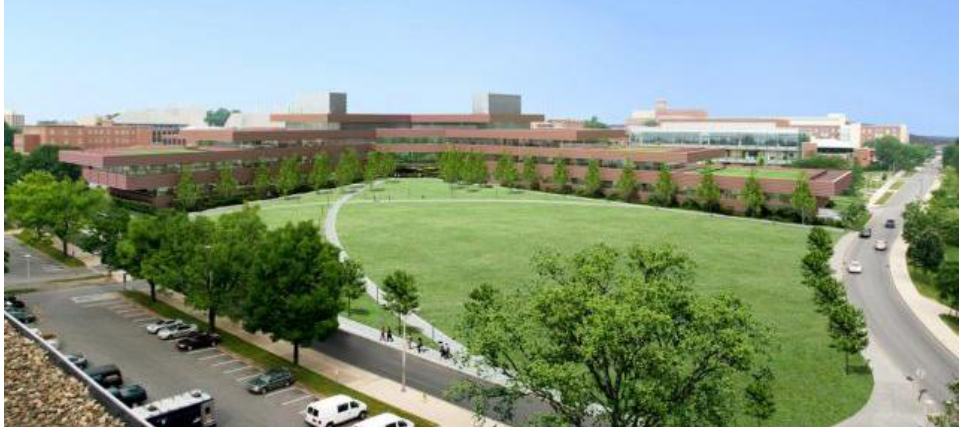
Figure 3 A model rendering of the Millennium Science Complex created by Viñoly